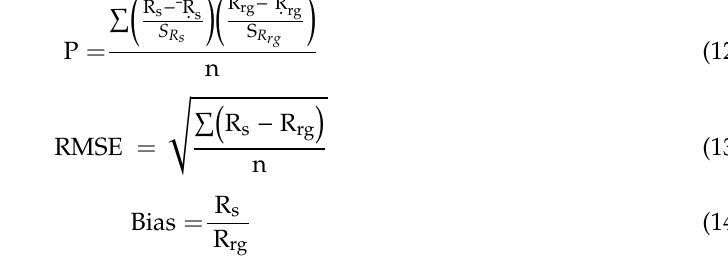
Table 3. Average quantitative error (RMSE) and bias ratio for all ground rain gauge before and after the downscaling process. * Bandar AMBS: Bandar Al-Muktafi Billah Shah.